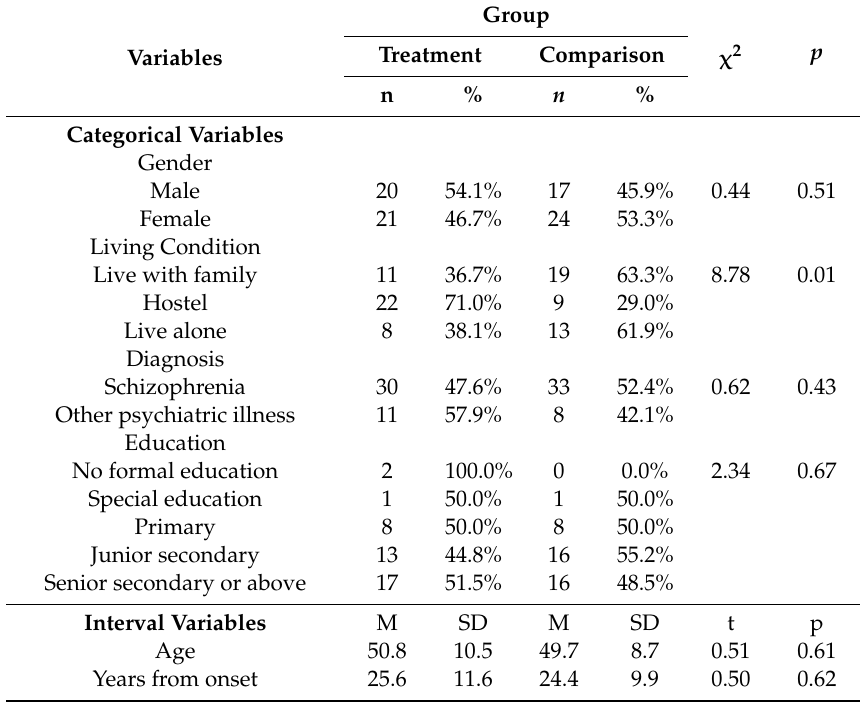
χ 2 p Treatment Comparison